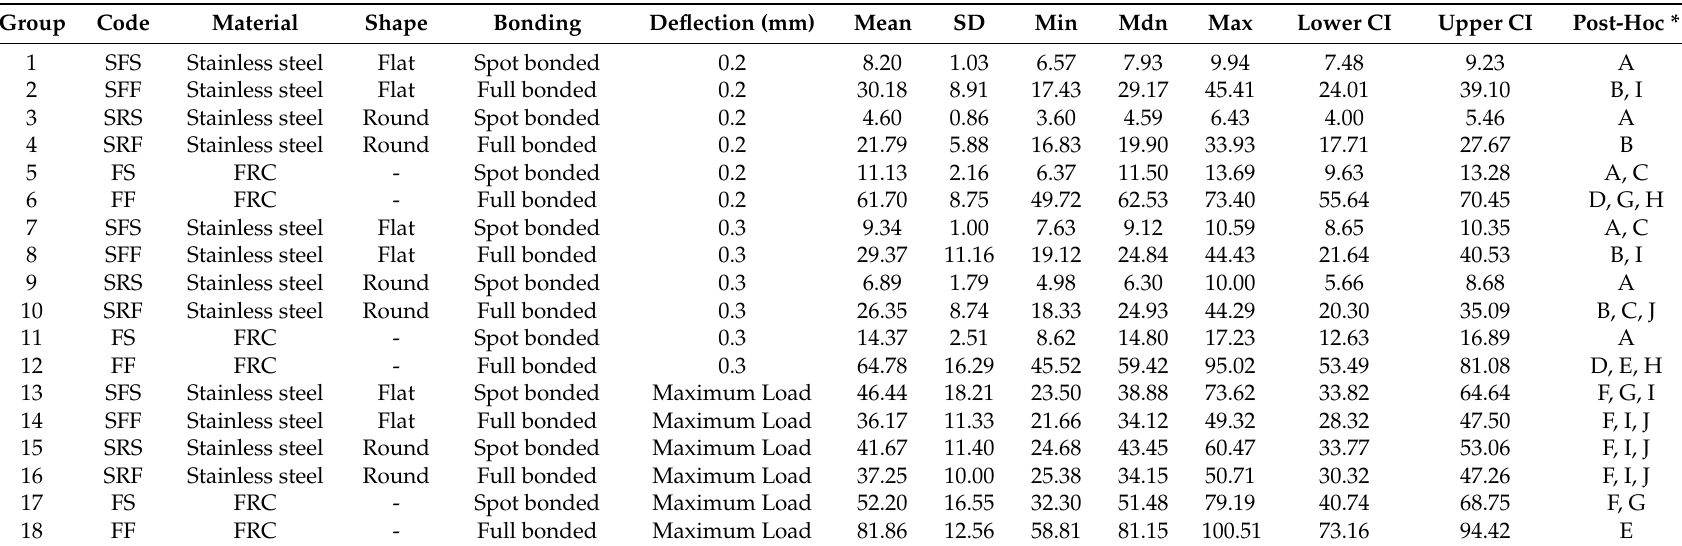
Table 2. Descriptive statistics (N) of the load values of the 18 groups tested (each group consisted of 10